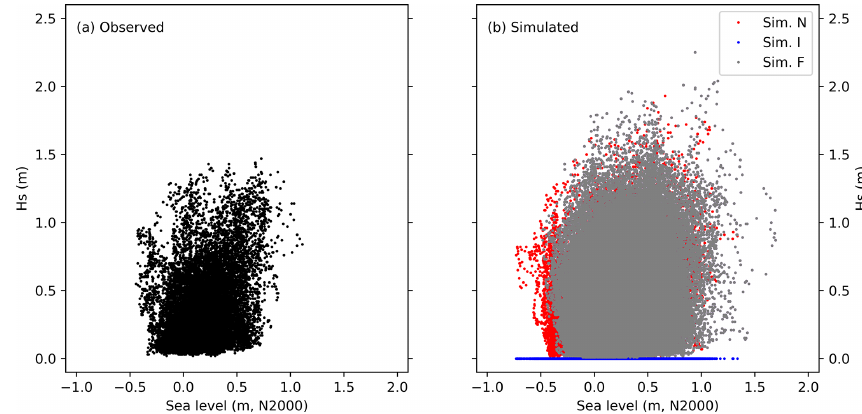
Figure 3. Scatter plot of significant wave heights vs sea level: (a) observed wave heights from 2016 to 2019 and (b) simulated wave heights from 1992 to 2019, data sets F (grey), I (blue), and N (red). Note that every data point of the set F (ice-free time) is also included in sets